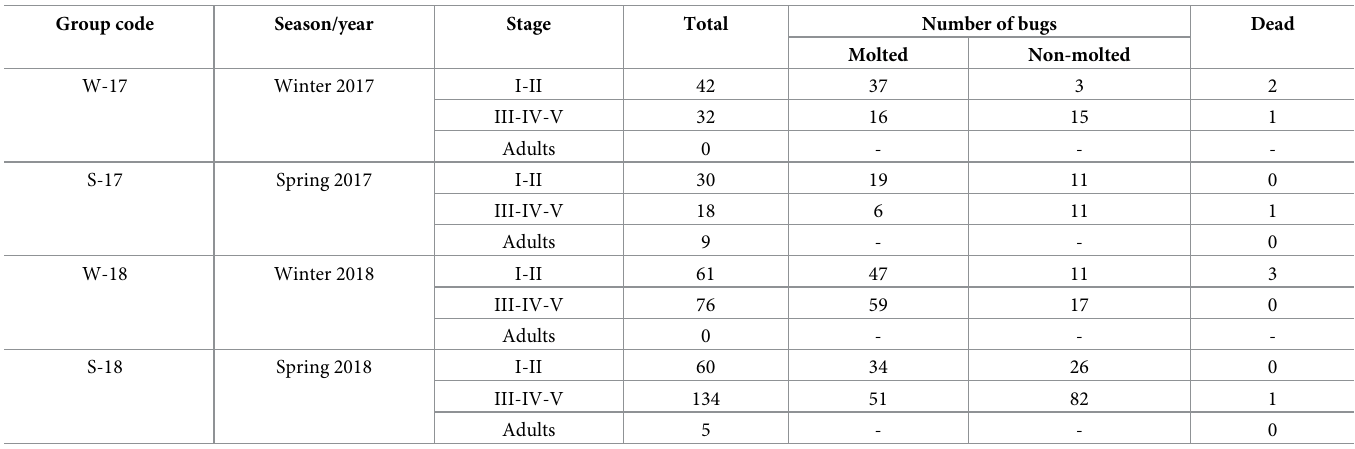
Table 1. Number of Mepraia spinolai individuals, shown by development stage, collected in the field in two seasons of two consecutive years and laboratory fed. Group